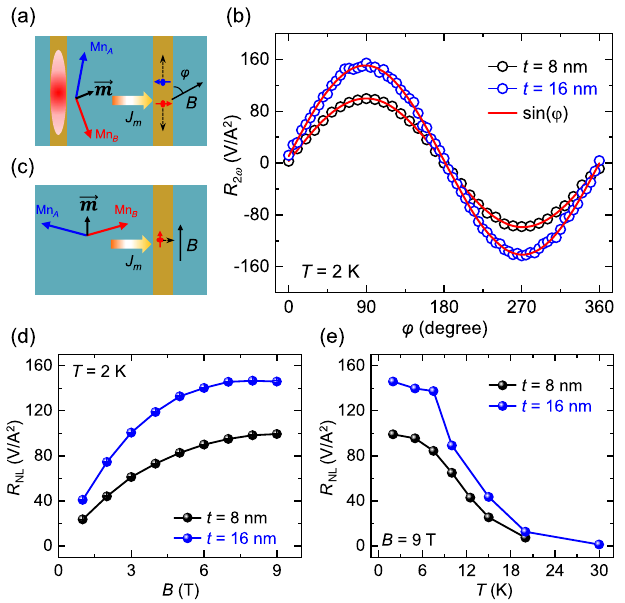
FIG. 2. Nonlocal magnon transport measurements in quasi-2D antiferromagnet MnPS 3 . (a) Schematic of the generation, trans- port, and detection of magnon-mediated spin current in MnPS 3 magnon devices. (b) The nonlocal resistances of the 8-nm and 16-nm MnPS 3 devices ( d ¼ 2 μ m) as a function of the in-plane magnetic field angle at T ¼ 2 K and B ¼ 9 T. (c) Illustration of the zero voltage signal when the magnetic field angle is 0°. (d) The in-plane magnetic field dependence of the nonlocal magnon signal for both MnPS 3 devices at T ¼ 2 K. (e) The temperature dependence of the nonlocal magnon signal for both MnPS 3 devices at B ¼ 9